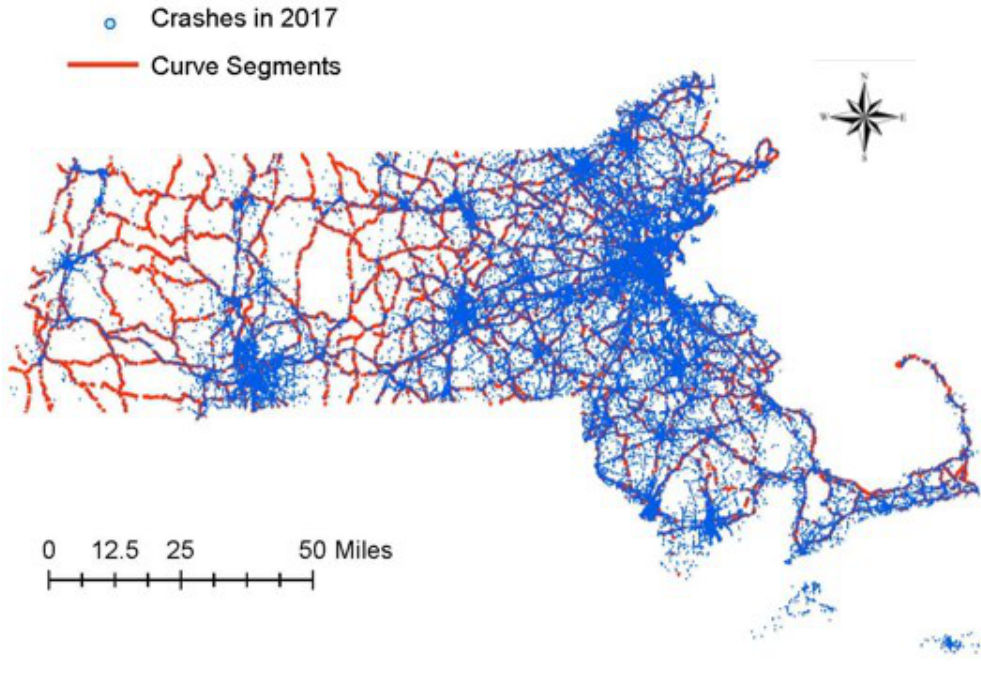
Figure 1 Massachusetts curve segments and crashes in